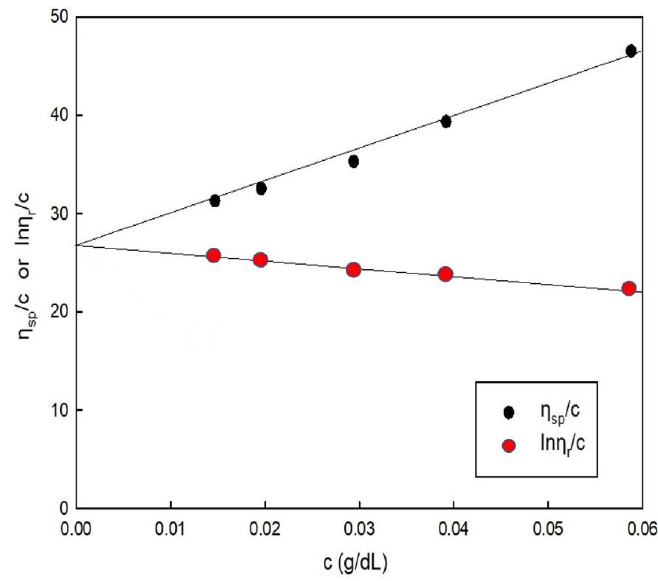
Figure 2. Inherent and reduced viscosity of polysuccinimide measured in DMF (0.1 M LiCl) at 25 °C (average values of three measurements).